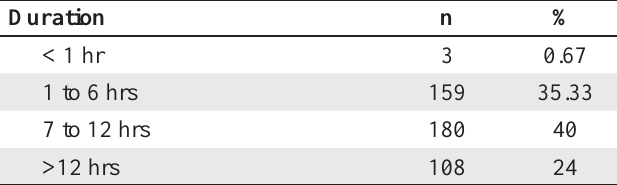
Table 1: Prehospital delay in the study population (n=450) Duration